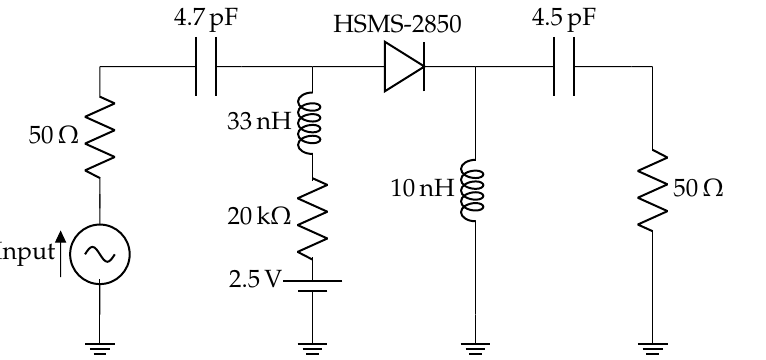
Figure 6. The developed biasing circuit for HSMS-2850.